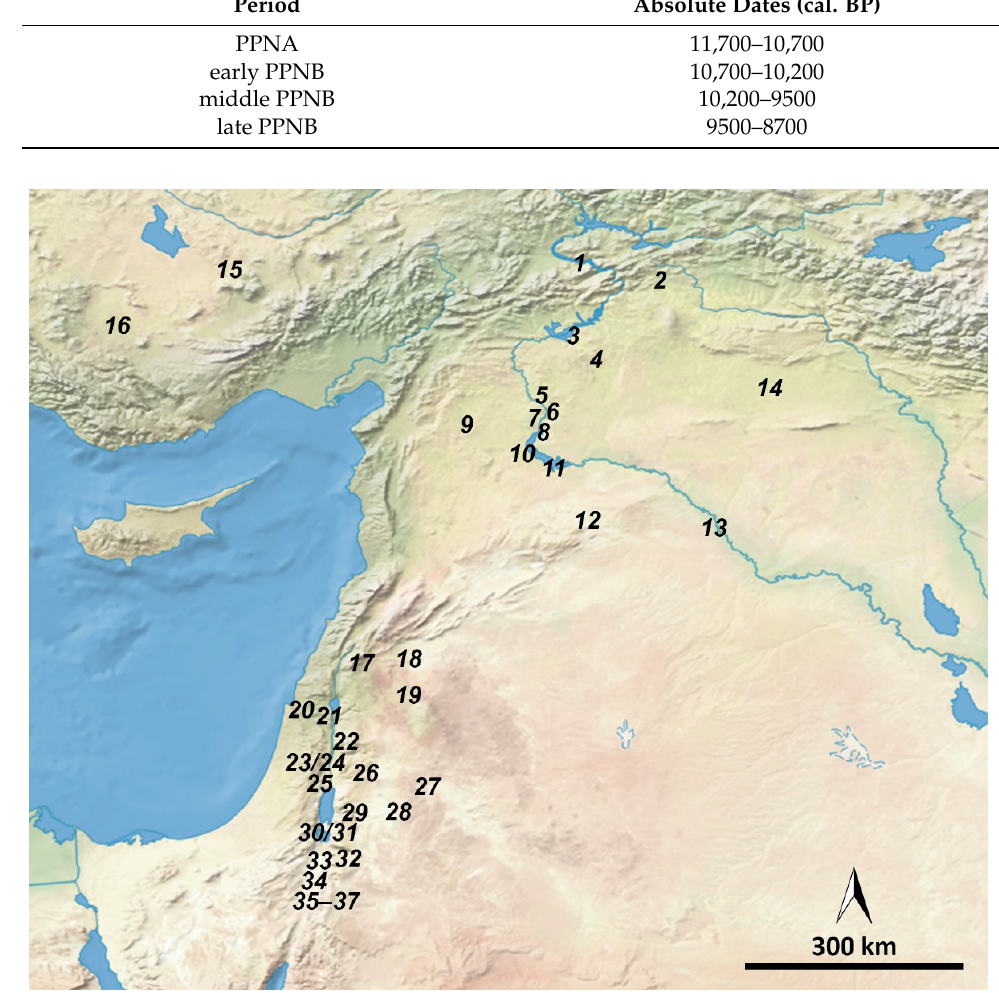
selected for within less than 200 years, even under conditions of unconscious selection [14]. Table 1. Chronology of the Pre-Pottery Neolithic (PPN). Dates based on [15,16]. Period